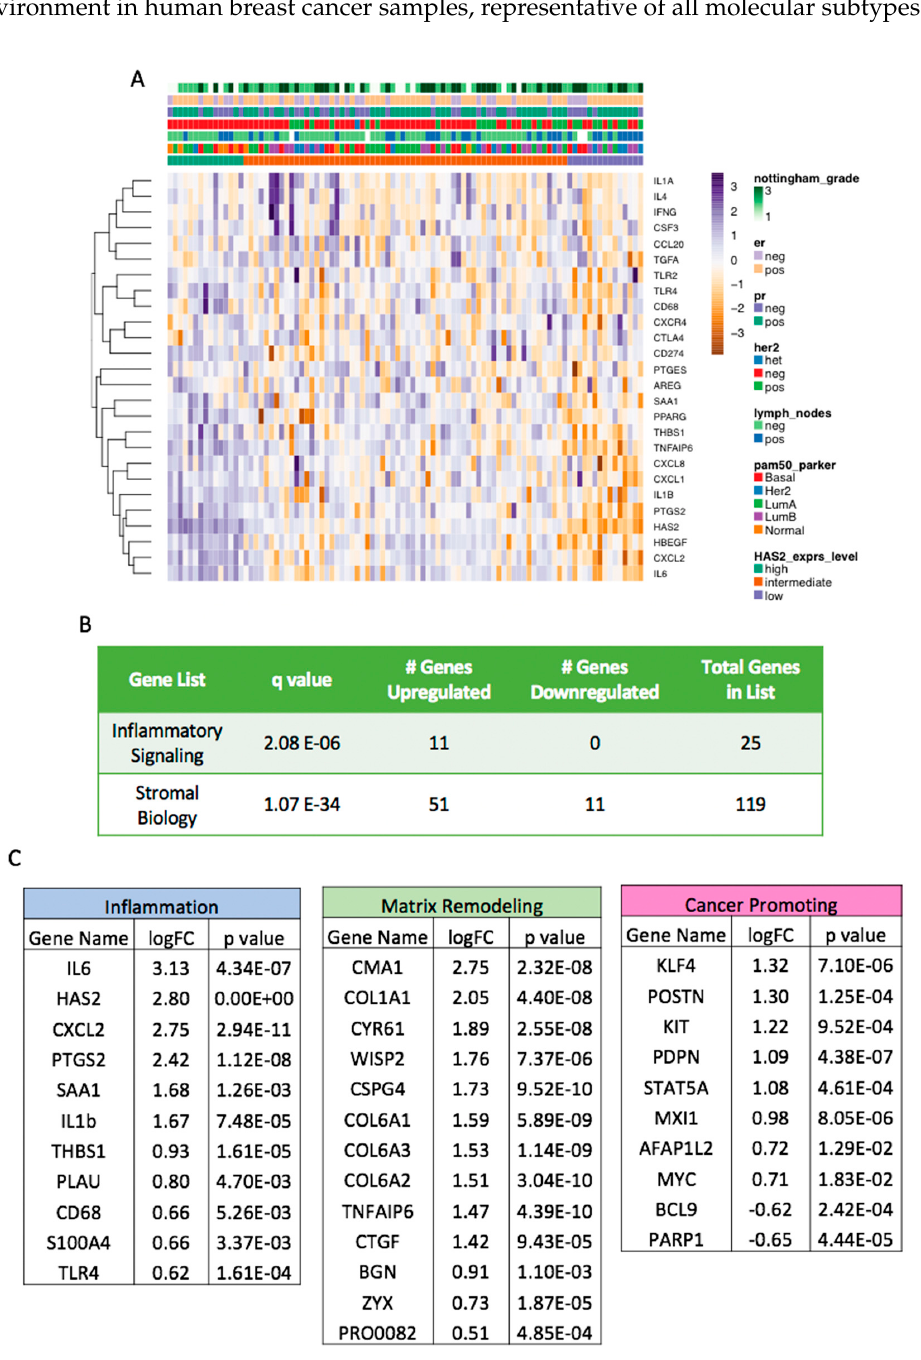
Figure 7 . Increased HAS2 gene expression is associated with inflammatory and stromal biology gene signatures in human cases of breast cancer. ( A ) Hierarchical clustering of gene expression based on ordering of patient samples by classification, as HAS2-high ( n = 15), HAS2-low ( n = 15), or HAS2-intermediate ( n = 64). HAS2-high cases (left side of heat map) show increased expression of a focused inflammatory signaling pathway. ( B ) Fisher’s exact testing demonstrated significant association of a focused inflammatory signaling gene signature and a larger stromal biology gene signature in genes differentially expressed between HAS2-high and HAS2-low breast cancers (see also Supplementary File S1). ( C ) Relevant genes and pathways demonstrating significant di ff erential expression in HAS2-high vs. HAS2-low breast